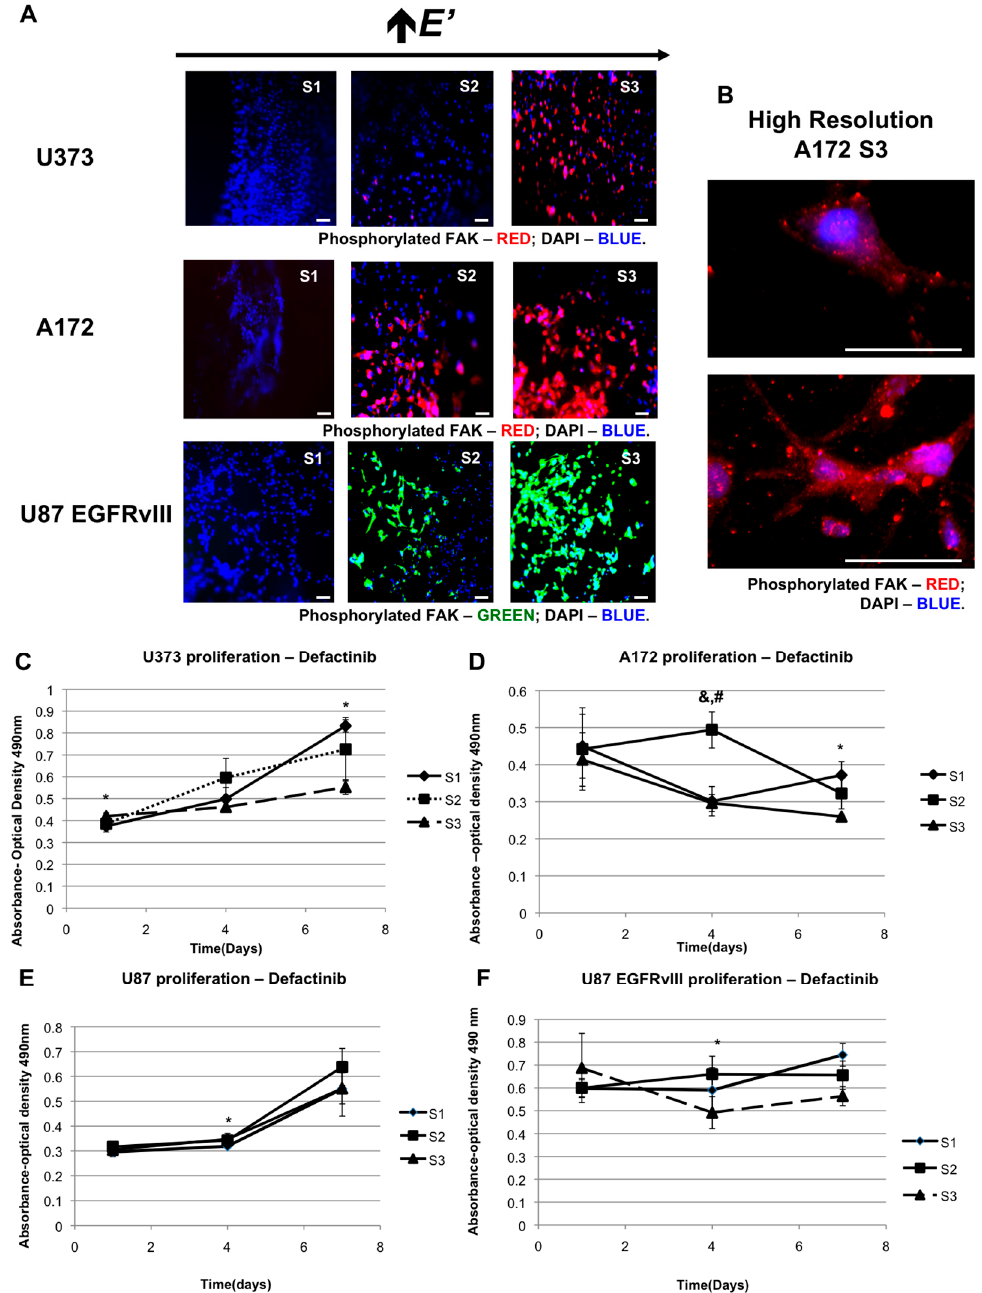
Figure 3. Focal adhesion kinase (FAK) expression increases with elastic modulus. ( A ) Immunofluorescent staining for phosphorylated FAK in U373 cells, A172 cells and U87EGFRvIII cells at S1, S2, and S3. Scale bars—100 µ m; ( B ) Increased resolution imaging of FAK expression at S3. Scale bars—50 µ m. ( C – F ) Proliferation of glioblastoma (GBM) cell types on varying elastic moduli under inhibition of FAK phosphorylation with defactinib: U373 cells ( C ), A172 cells ( D ), U87 ( E ) and U87 EGFRvIII cells ( F ). * denotes p -value was less than 0.05 when S1 and S3 values were compared, & denotes p -value was less than 0.05 when values of S2 and S3 were compared, and # denotes when the p -value was less than 0.05 when S1 and S2 values were compared.